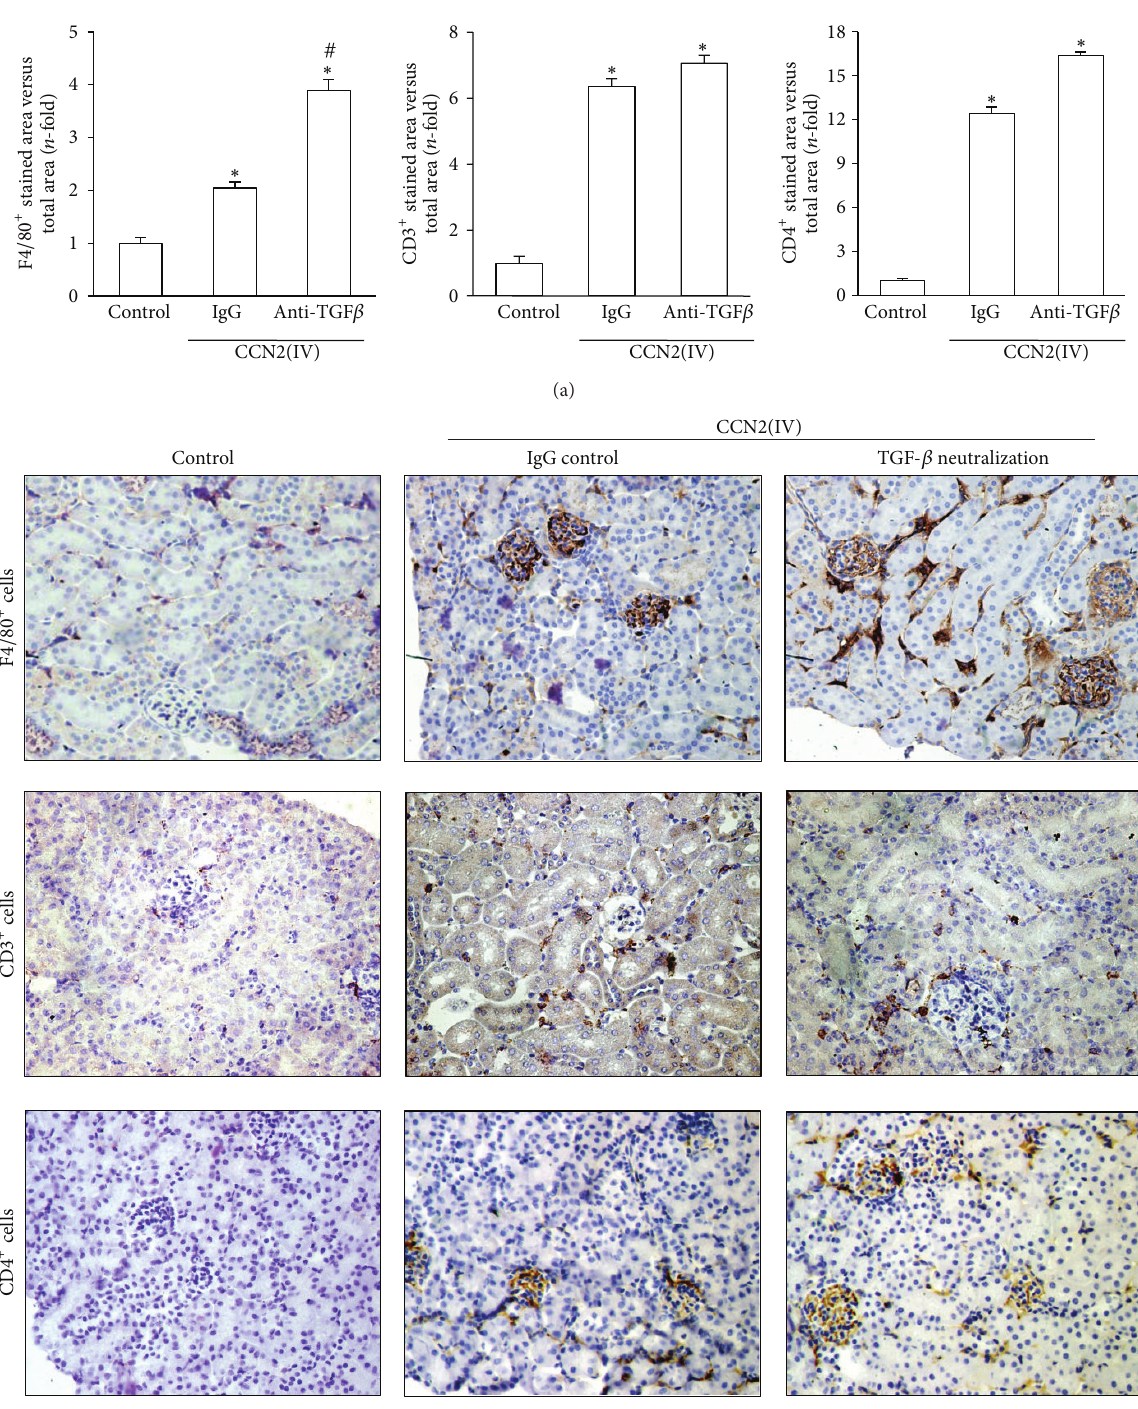
Figure 2: TGF- 𝛽 neutralization increases CCN2(IV)-induced renal inflammatory response. The inflammatory cell infiltration was characterized in paraffin-embedded renal sections by immunohistochemistry with anti-F4/80 (specific for monocyte/macrophage), anti- CD3 (T lymphocyte marker), and anti-CD4 (effector lymphocyte T marker) antibodies. (a) shows the immunohistochemistry quantification expressed as mean ± SEM ( 𝑛 = 10 animals per group) of fold-change as compared to controls. Mean ± SEM. ∗ 𝑃 < 0.05 versus control. # 𝑃 < 0.05 versus CCN2(IV)-IgG. (b) shows a representative animal from each group (200x magnification). Arrows indicate infiltrating cells in detail (400x